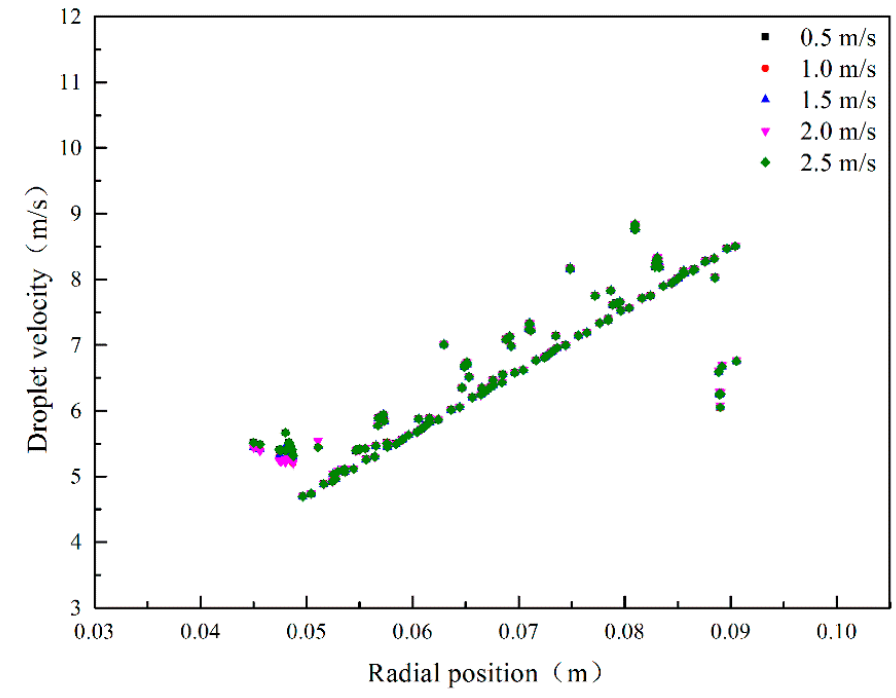
Figure 7. The e ff ect of initial droplet velocity on droplet velocity in the packing Figure 7. The effect of initial droplet velocity on droplet velocity in the packing zone.